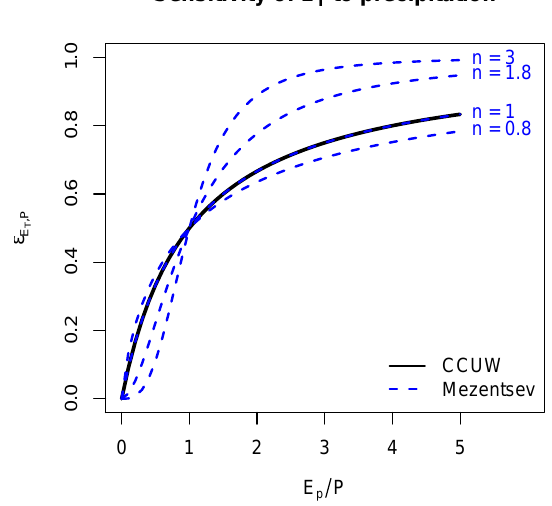
Fig. 5. Sensitivity (elasticity) of basin evapotranspiration with re- spect to changes in precipitation ( ε E ). The bold black line de- T ,P picts elasticity of the CCUW, while the dashed line shows different elasticities for the Mezentsev function. The elasticity of the CCUW corresponds with the slope of the curves shown in the top right panel of Fig.